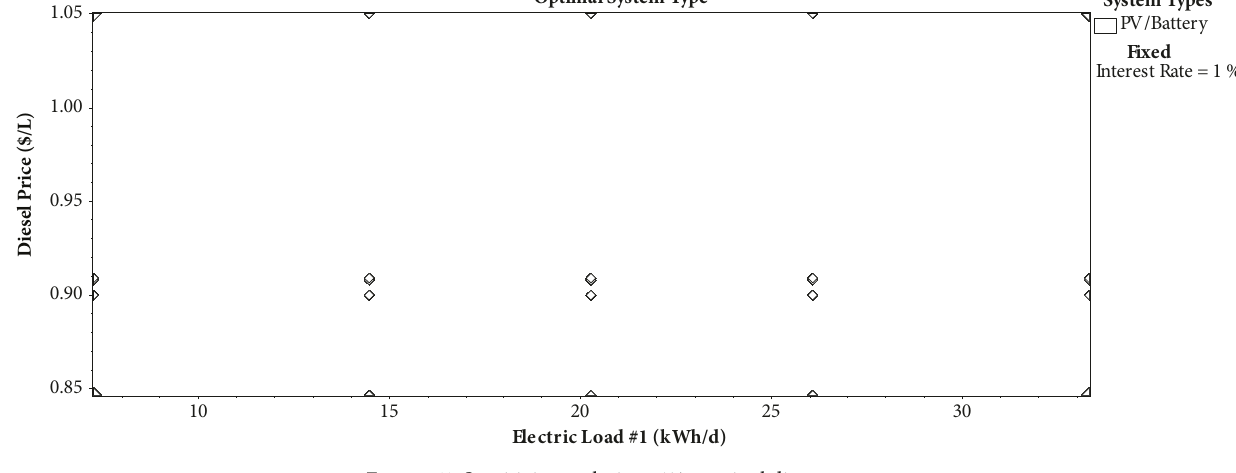
Figure 11: Sensitivity analysis at 4% nominal discount rate.